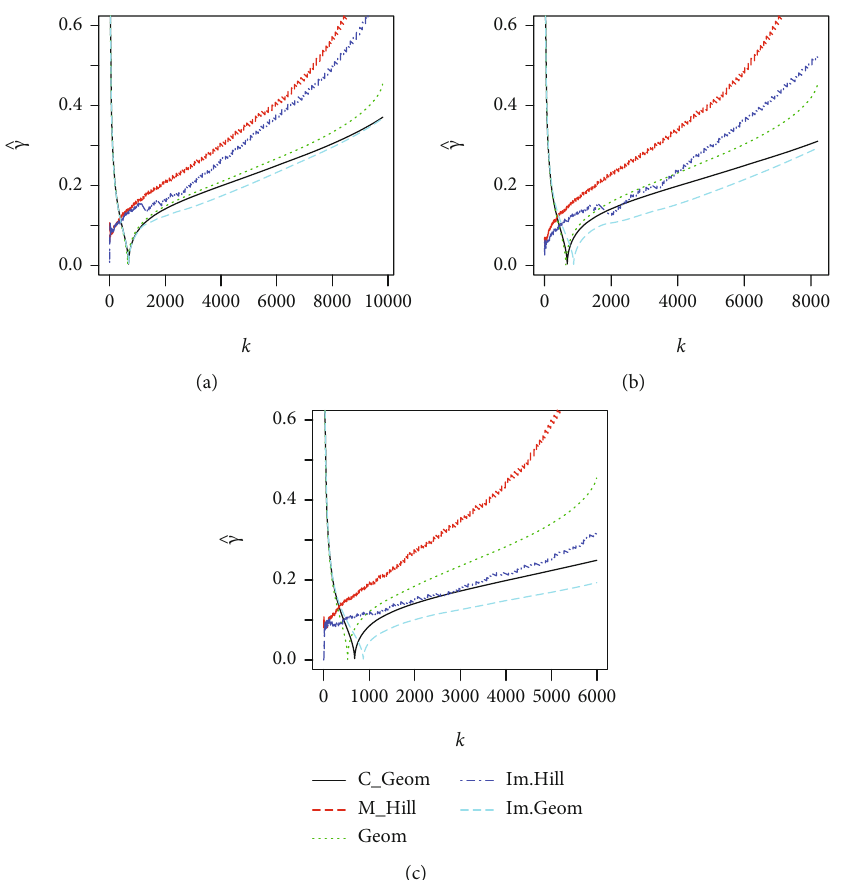
Figure 7: Tail index estimators on wind speed dataset with missing observations. (a), (b), and (c) represent 10%, 25%, and 45% missingness in the datasets,